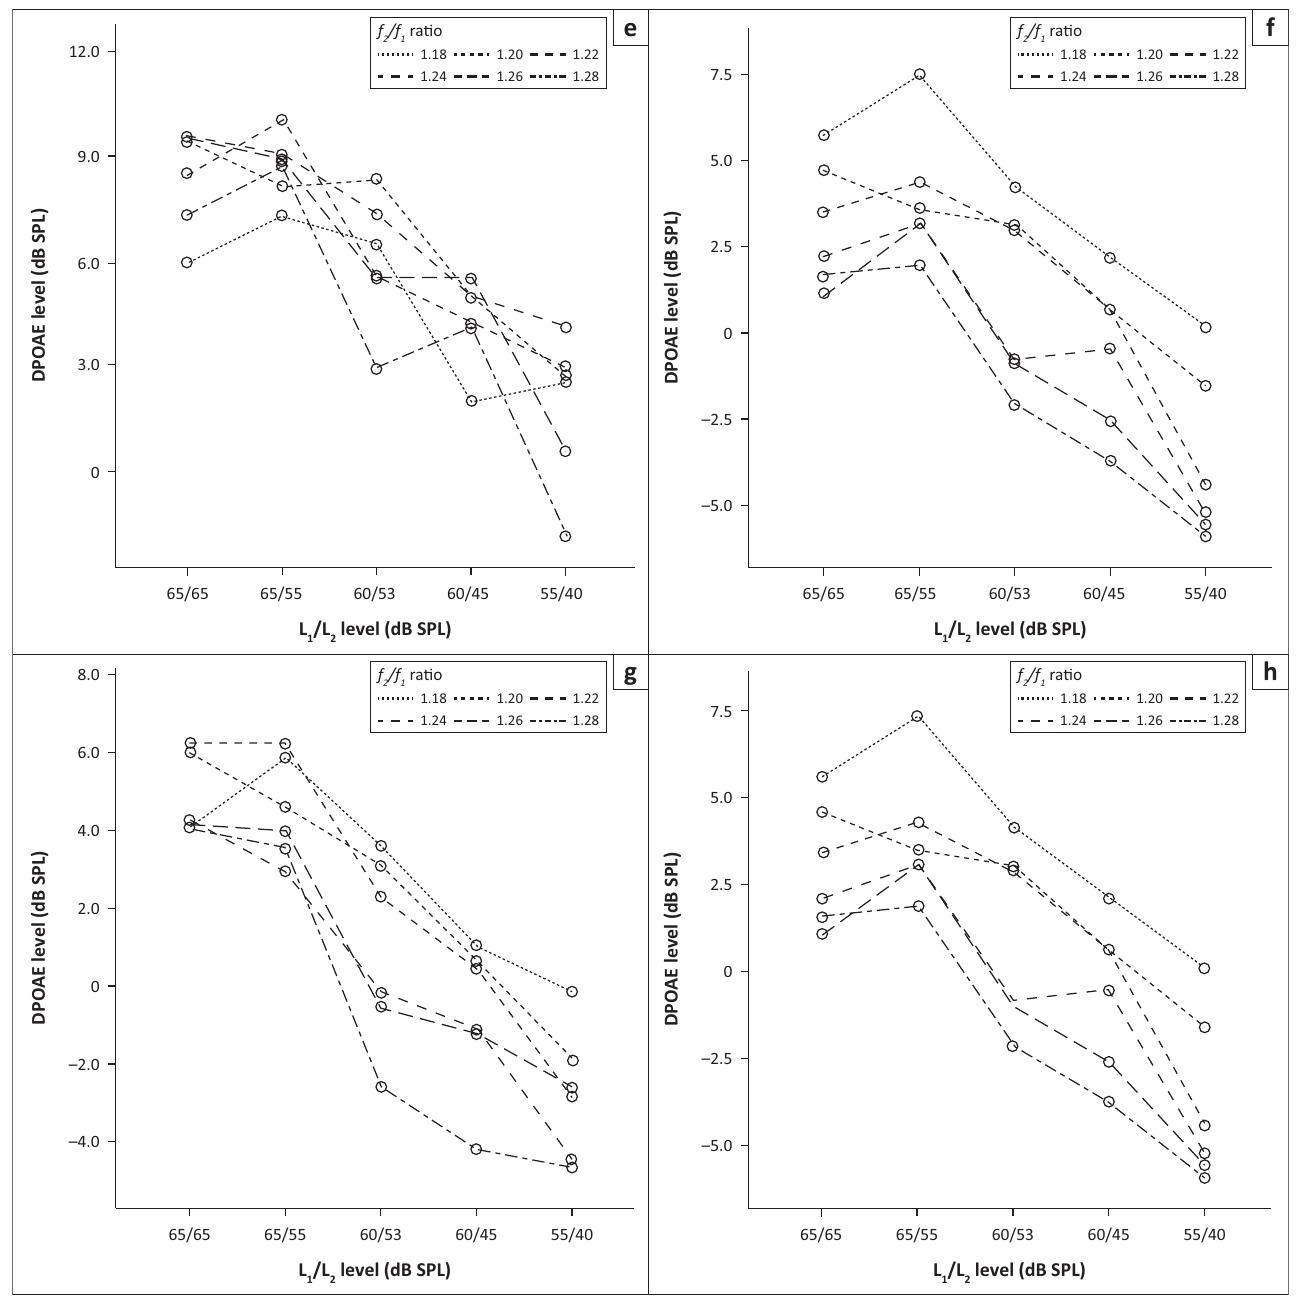
DPOAE, Distortion product otoacoustic emissions. FIGURE 1 (Continues...): Mean distortion product otoacoustic emission absolute levels per intensity and frequency ratio combinations for each frequency ( f at 2003 Hz, (b) left ear at 2003 Hz, (c) right ear at 2519 Hz, (d) left ear at 2519 Hz, (e) right ear at 3175 Hz, (f) left ear at 3175 Hz, (g) right ear at 3996 Hz, (h) left ear at 3996 Hz, (i) right ear 5000 Hz, (j) left ear at 5000 Hz, (k) right ear at 6996 Hz, (l) left ear at 6996 Hz, (m) right ear at 8003Hz and (n) left ear at 8003Hz. Hz,